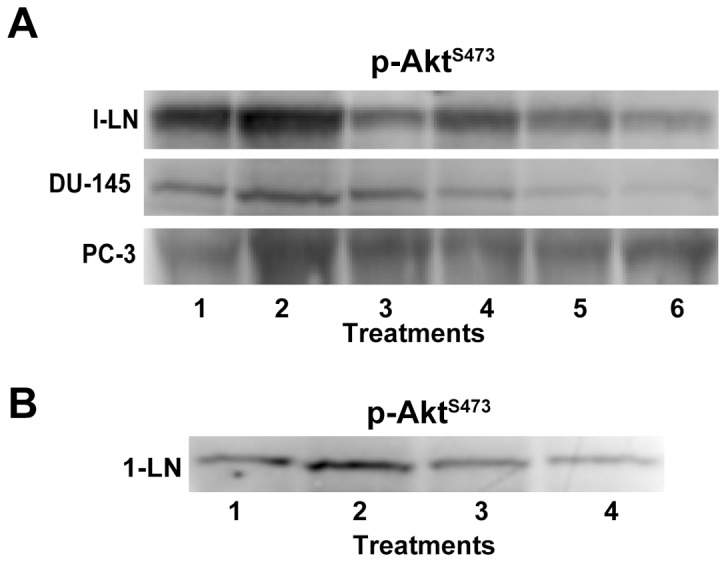
Inhibition of 8-CPT-2Me-cAMP-induced activation of p-AktS473 in Rictor immunoprecipitate by COX-2 inhibitors (Panel A) and a mTOR inhibitor (Panel B).A representative immunoblot of p-AktS473 from three independent experiments are shown in Panel A and Panel B. The lanes in immunoblot in Panel A are: (1) buffer; (2) 8-CPT-2Me-cAMP (100 μM/30 min); (3) AH23848 (1 μM/3 h); (4) AH23848 then 8-CPT-2Me-cAMP (100 μM/30 min); (5) SC58125 (1 μM/3 h) and (6) SC58125 then 8-CPT-2Me-cAMP (100 μM/30 min) and the lanes in Panel B are: (1) buffer; (2) 8-CPT-2Me-cAMP (100 μM/30 min); (3) Torin (250 nM/3 h) and (4) Torin then 8-CPT-2Me-cAMP (100 μM/30 min).